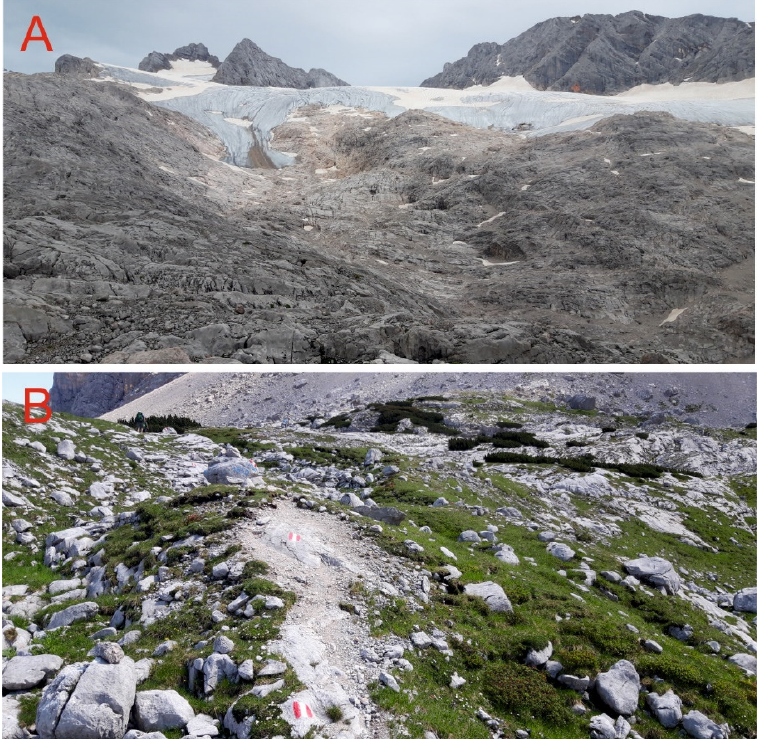
Figure 2. ( A )—Upper part of the Hallstätter Glacier foreland, ( B )—Little Ice Age moraine. Table 1. Position of centrally located rock surfaces within each test